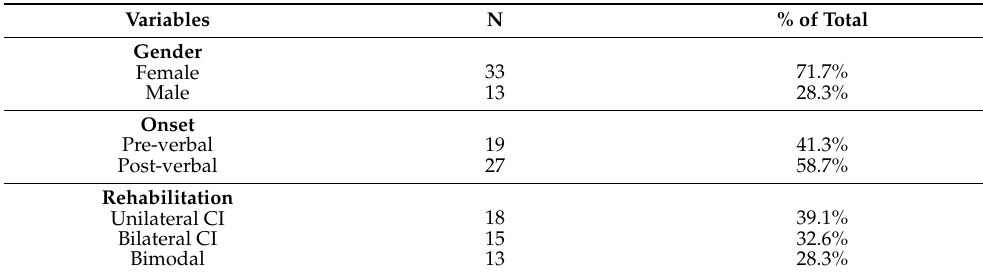
Abbreviations: CI (cochlear